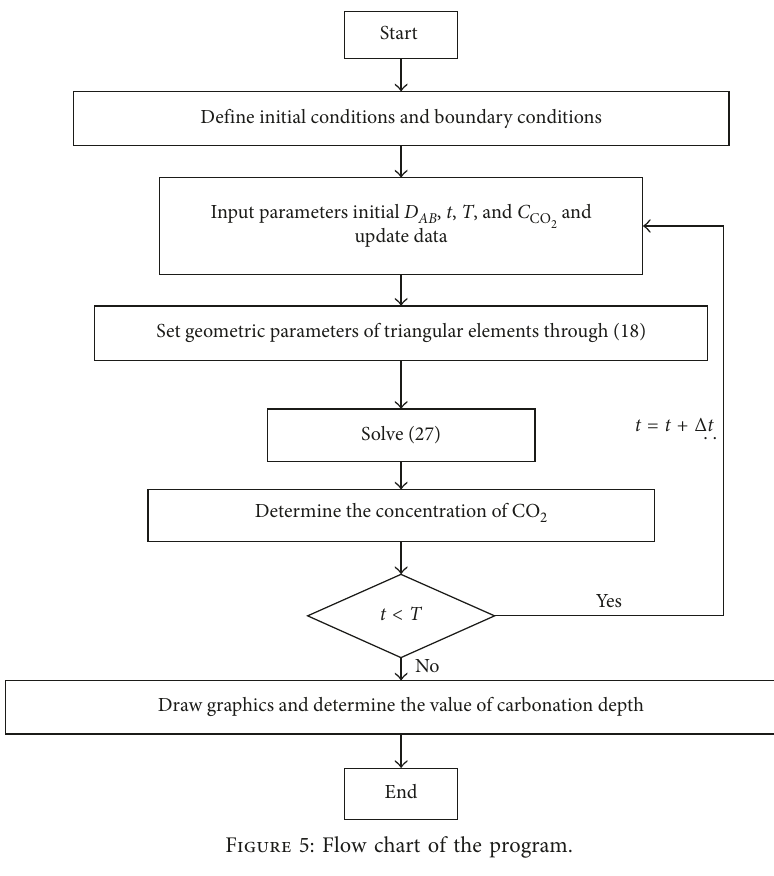
Figure 5: Flow chart of the